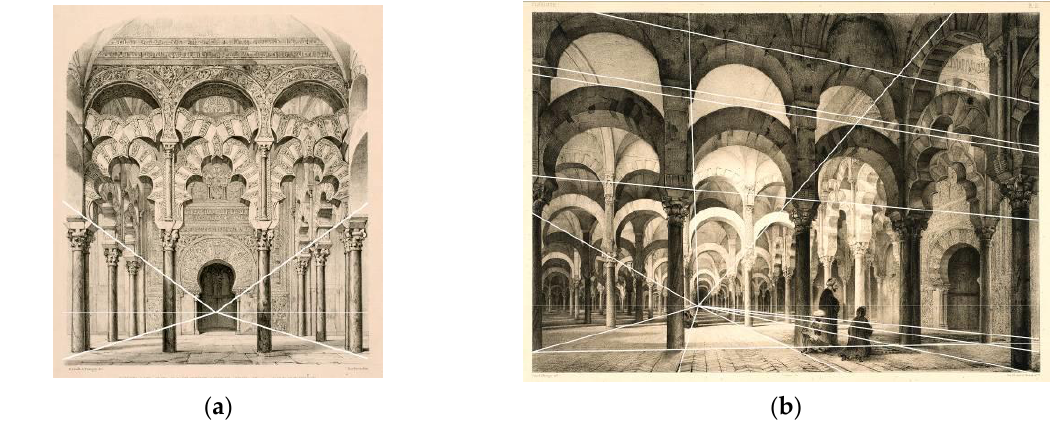
Figure 18. Horizon and vanishing lines on the Girault de Prangey perspectives: ( a ) Mihrab front view; ( b ) Forest of columns and mihrab view. Source: Own production.